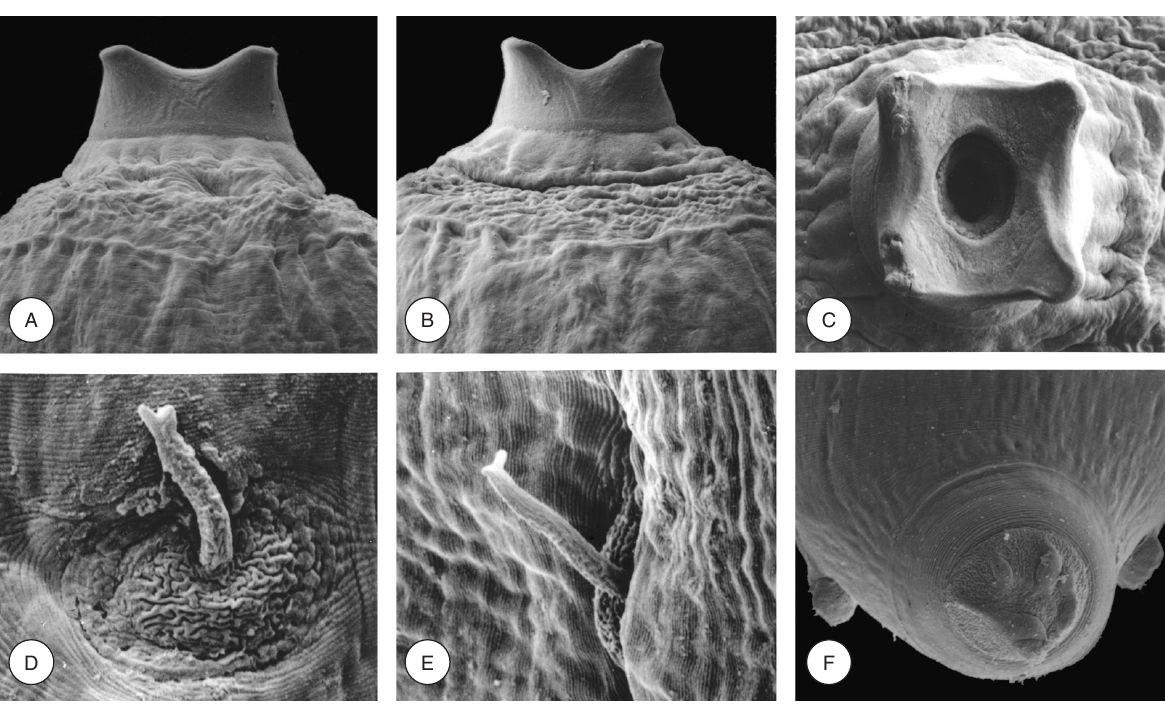
FIG. 1 Setaria thwaitei